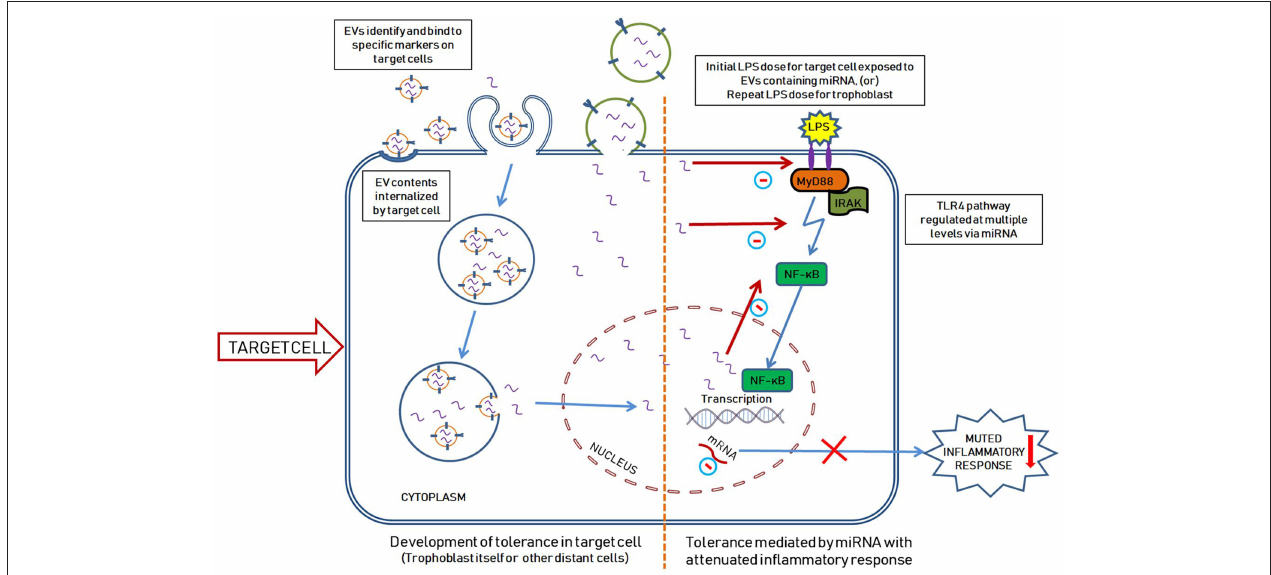
FIGURE 2 | Hypothetical illustration showing the development of endotoxin tolerance in a target cell mediated by miRNA packaged within the EVs. EVs carrying miRNAs (and other contents) are released from the original placental trophoblasts upon exposure to initial LPS dose as seen in Figure 1 . The released EVs travel to the target cells where they are selectively internalized by different mechanisms as shown. Microvesicles are internalized into the cytoplasm by fusing with the cell membrane while exosomes are internalized into vesicular bodies, lipid rafts on cell surface or by directly binding with specific cell surface receptors ( 96). The target cell in this scenario can represent a distant cell (exposed to first dose of LPS) or the original trophoblast cell (exposed to a second dose of LPS). We hypothesize that the miRNAs within the EVs are released into the cytoplasm and enter the nucleus thereby negatively regulating the inflammatory pathway at multiple levels (including direct inhibition of TLR4, downregulating mRNA translation of TLR and negative feedback for NF- κ B mediated TLR4 pathway). Upon exposure to a second dose of LPS, the original tolerized cell generates an attenuated inflammatory response (since it has high levels of anti-inflammatory miRNAs as a result form the first LPS